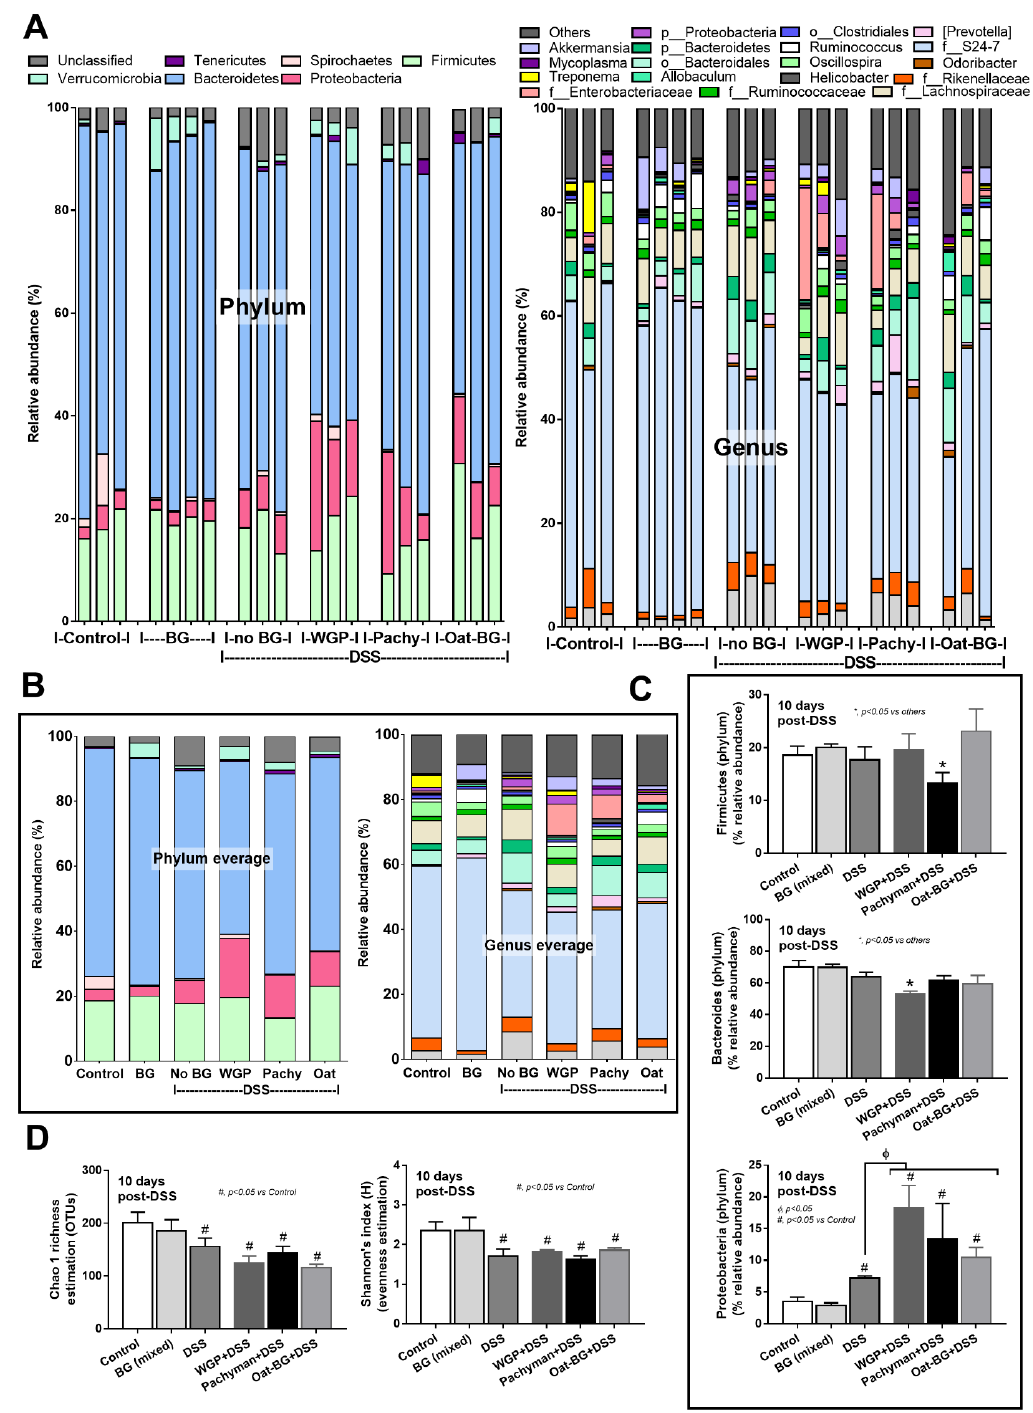
Figure 3. Fecal microbiome analysis from mice. Dextran sulfate solution (DSS) with or without several glucans using whole-glucan particles (WGP), Pachyman, or Oat glucans (Oat-BG) was performed. Meanwhile, in nondrinking water (Control) with oral β -glucans gavage, only one of these glucans was used in each mouse, but the data are combined into the BG (mixed) group. Phylum and genus level determination ( A ), average value of the analysis ( B ), graph presentation in the phylum analysis ( C ), and bacterial diversity ( D ) are shown ( n = 3–4/group). #, p < 0.05 vs. Control; *, p < 0.05 vs. other groups; φ , p < 0.05 vs. the indicated group as determined by ANOVA with Tukey’s analysis. Data from oral glucan-administered mice using different types of glucans were combined as BG (mixed) due to the nonsignificant differences between these